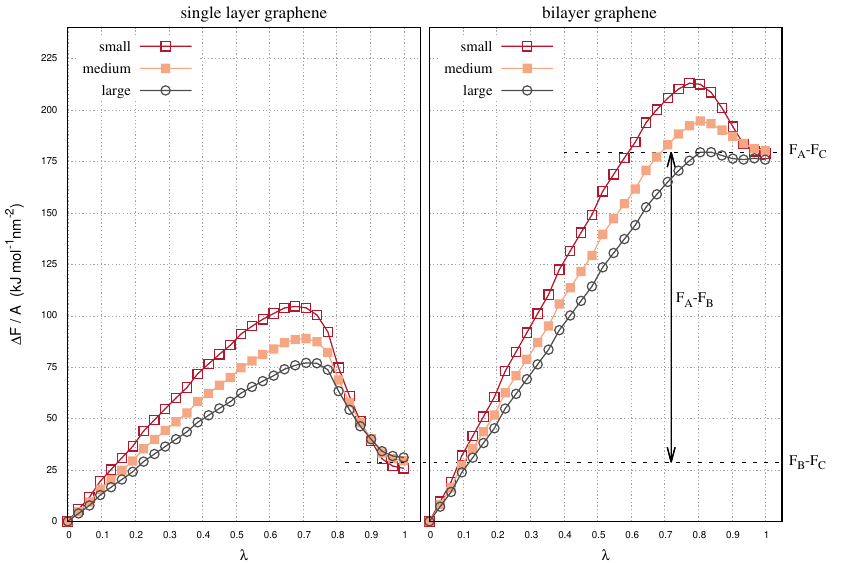
Figure 3. Cumulative free energies as a function of the decoupling parameter, λ , for the single and bilayer graphene samples with small, medium and large size. The free energy values are normalized by the area size of the graphenes.